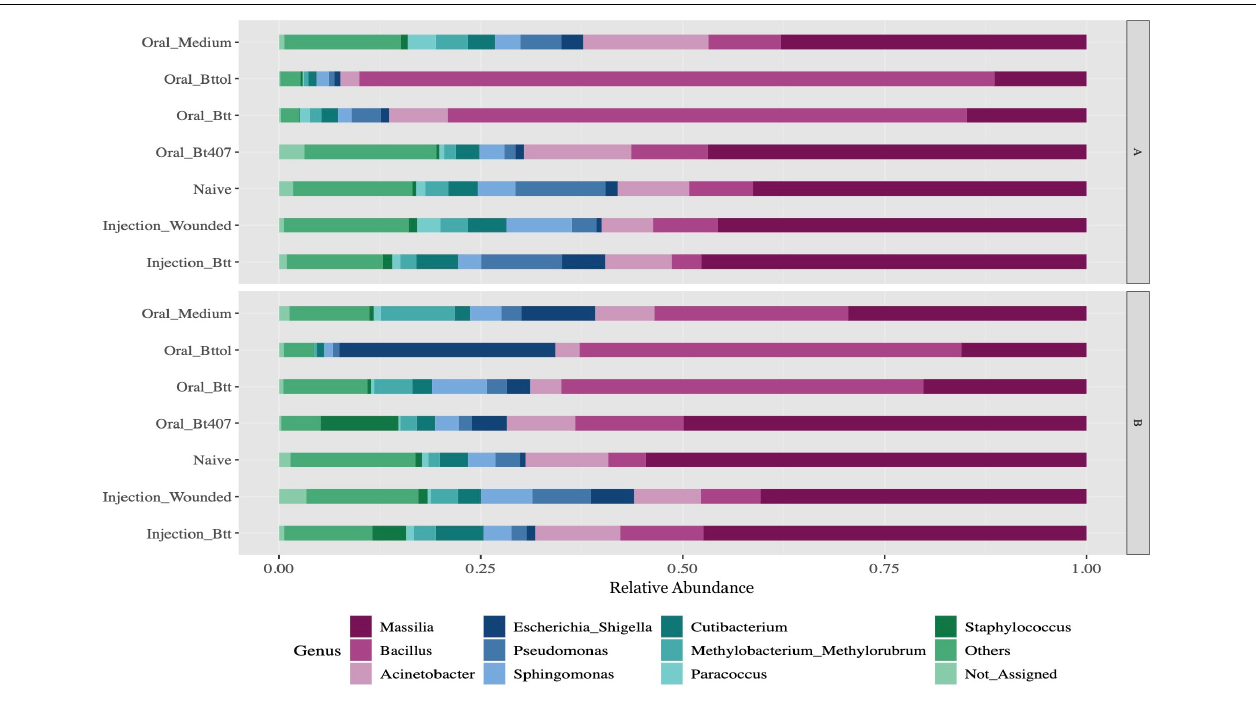
FIGURE 2 | Relative microbiome composition of red flour beetle larvae based on bacterial 16S rRNA gene profiling after seven different priming treatments in two time points (A: 24 h after priming, B: 4 days after priming). The y-axis indicates relative abundances (sums to 1 for each treatment) of all the ASVs detected. Each treatment corresponds to 12 replicates of 10 pooled larvae each. Only top 10 genus have been represented in the figure with all other genus being aggregated as Others. Not_Assigned represents all ASVs for which genus could not be assigned. For the absolute microbiome abundance, see Supplementary Figure 4